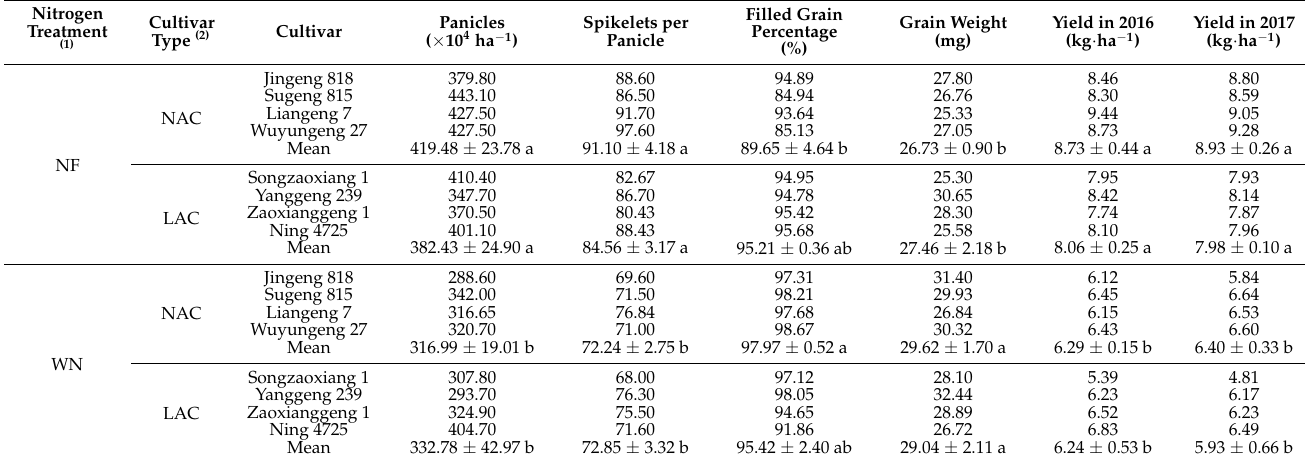
Table 2. Yield and yield components of the japonica rice cultivars with different contents of amylose, grown with or without nitrogen fertilization.